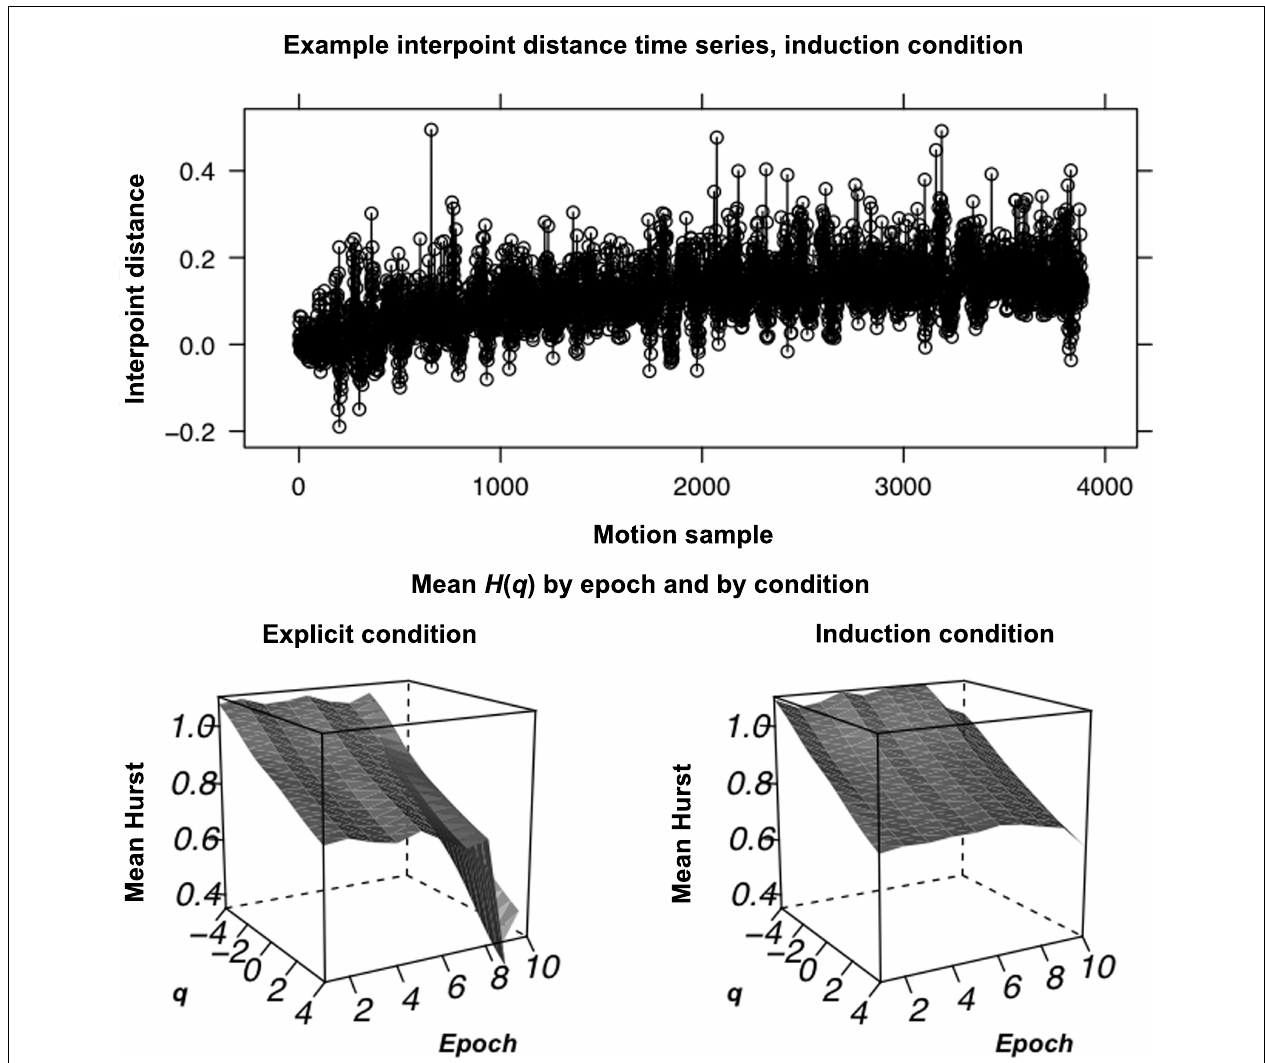
the trajectory of H (2) is simply decreasing in the explicit condition whereas H (2) follows more of an arc in the induction condition, first increasing and then decreasing on the approach to rule mastery.We sought to use vector error-correction (VEC) modeling to test whether H ( q ) for other q contributed to later changes in H